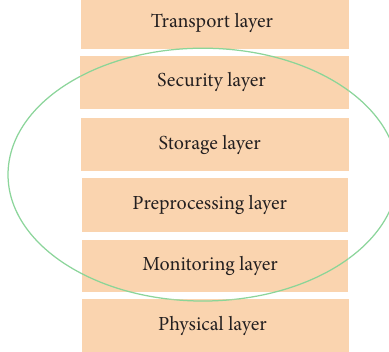
Figure 2: Fog architecture of a smart IoT